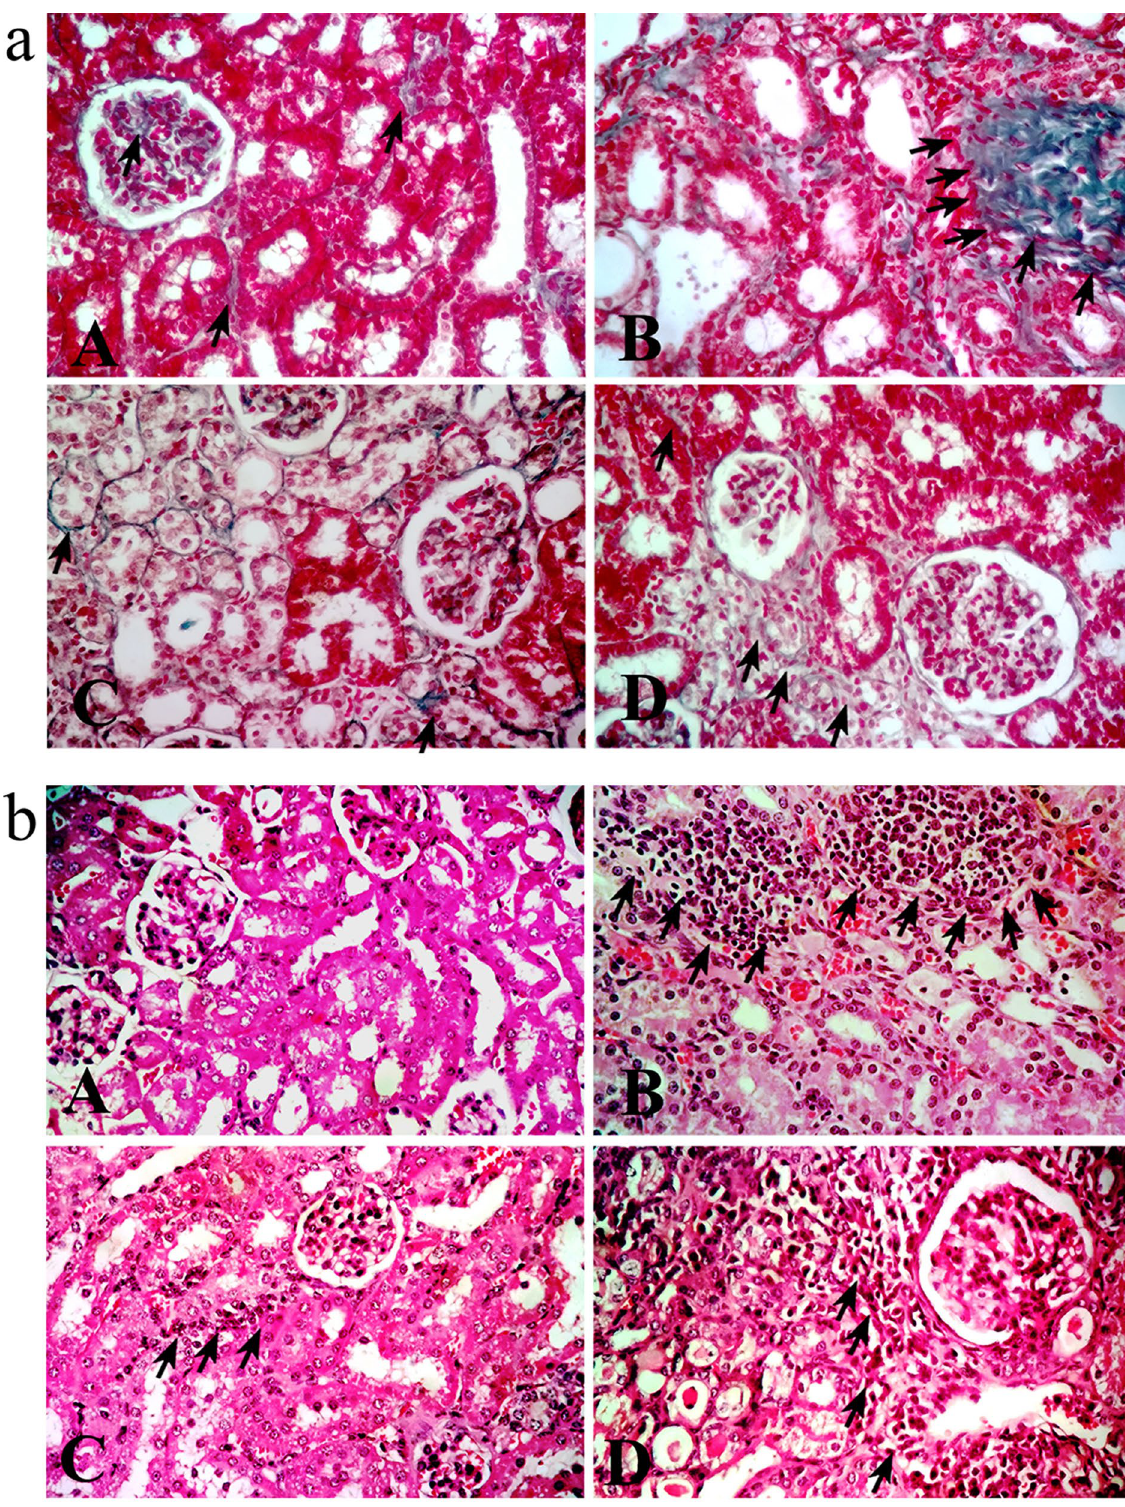
Figure 2. Representative photographs for kidney sections stained with a. Masson trichrome stain (× 400) showing fibrotic areas (arrows) ( b ). Hematoxylin–eosin stain (× 400) showing tubular injury and infiltration of inflammatory cells (arrows). A: control group B: adenine group C: erlotinib group D: adenine + erlotinib